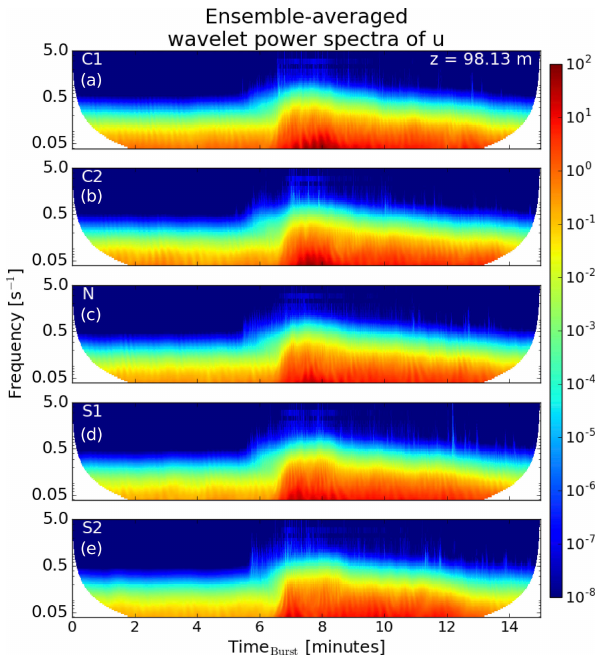
Figure 14. Ensemble-averaged wavelet power spectrum of u - component velocity (m 2 s − 1 ) at 98.13m using the Daubechies-5 wavelet for the C1, C2, N, S1, and S2 cases from top to bottom,